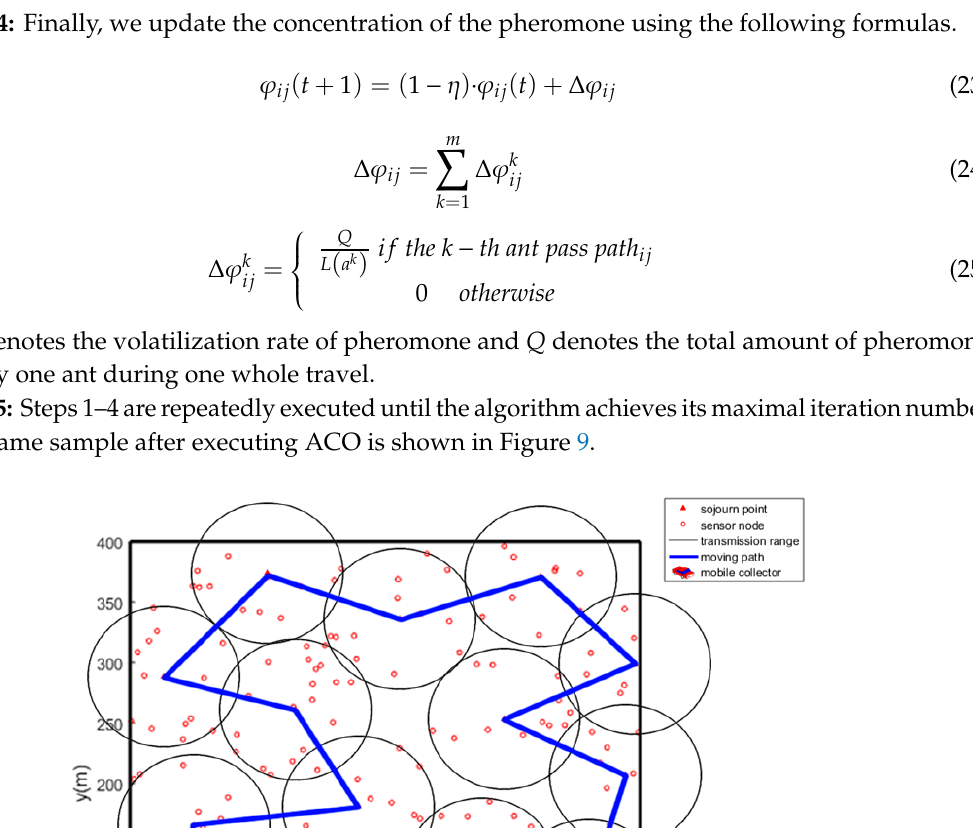
Table 2. Parameters for PSO and ACO.